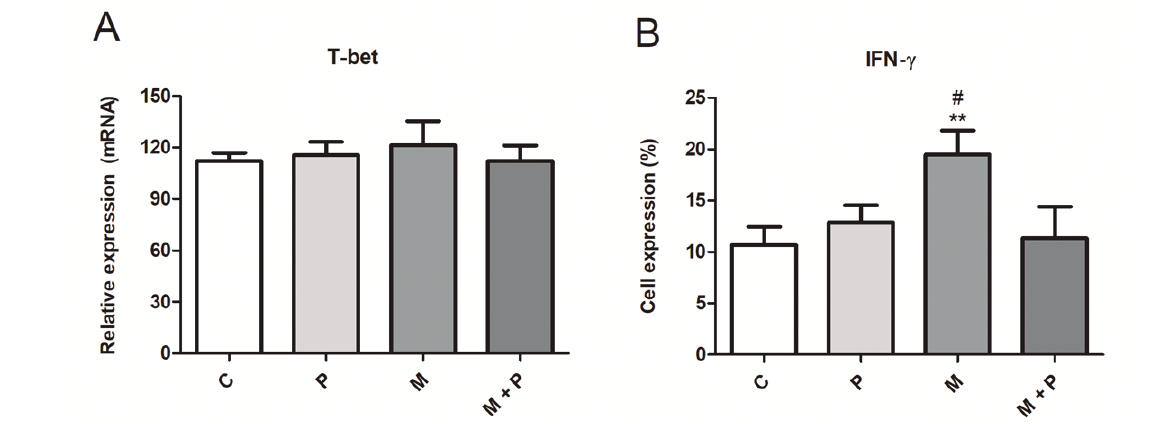
Figure 5. (A) T-bet relative expression and (B) percentage (%) of lymphocytes expressing IFN-γ after 120 h of co-culture with autologous dendritic cells treated with RPMI 1640 (control – C), MAGE-1 (M – 10 μg/mL), propolis (P – 5 μg/mL) or their combination. Data represent mean and standard deviation (n = 5). Significantly different from control: **( p < 0.01). Significantly different from M + P: # ( p <